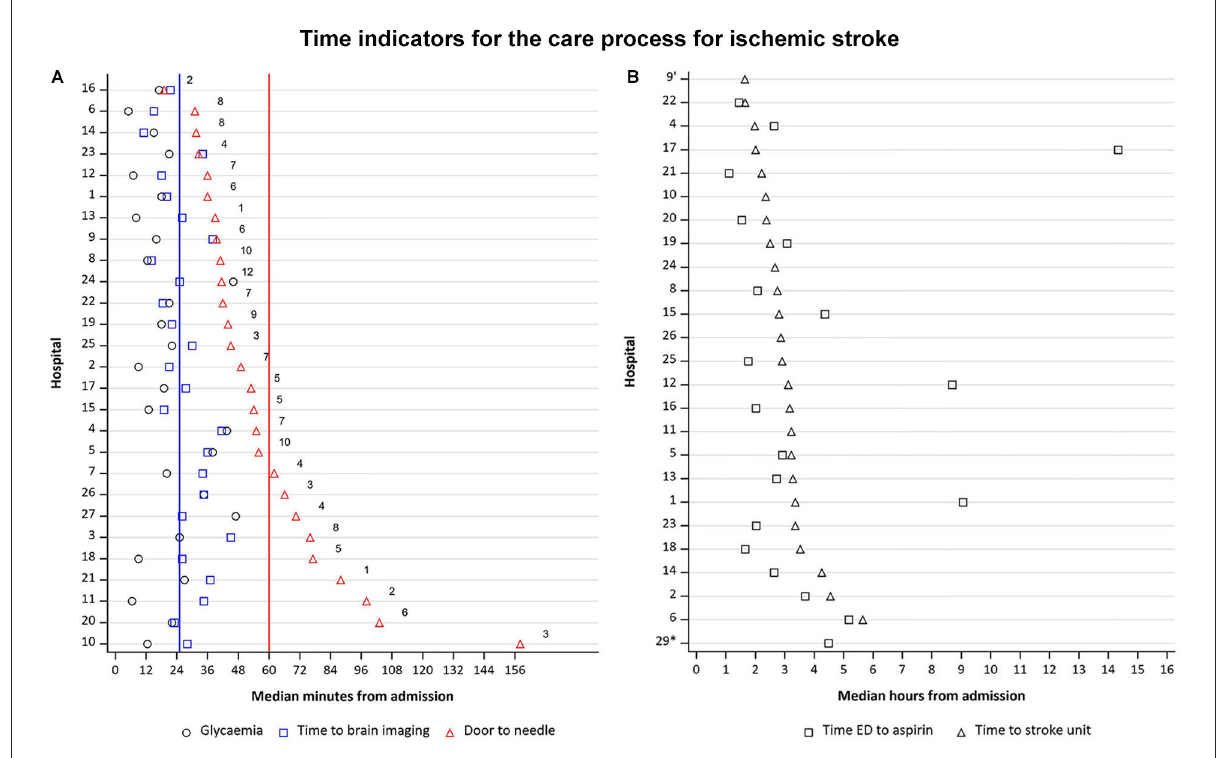
FIGURE2 (A) Time from ED arrival to glycemia measurement, to imaging, and door-to-needle time, if applicable, for early presenters. Recommendation for door-to-needle time, according to guidelines. Recommendation for time to brain imaging, according to guidelines Hospitals 28 and 29 are excluded from this figure as they had no data available for door-to-needle time. Numbers in the figure indicate the number of patients who were treated with thrombolysis. N = 326. (B) Time to SU admission and time to antithrombotic treatment for late presenters. ED, emergency department; SU, stroke unit Hospitals 3,7, 27 and 28 are excluded from this figure as they had no data available for time ED to aspirin and time to SU. * No SU available No data available on time from ED to aspirin administration N =